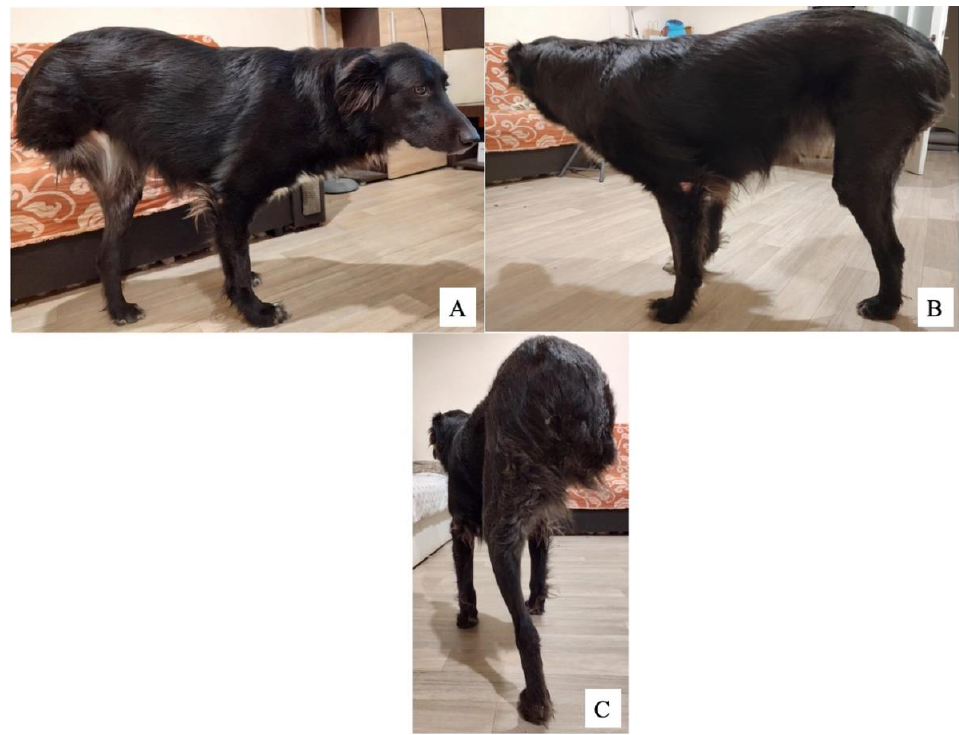
Figure 4. Photos of dog at 3 months postoperative: left lateral ( A ), right lateral ( B ), and caudal ( C ). Note the alopecic operated area on the left medial tibial crest ( A ).